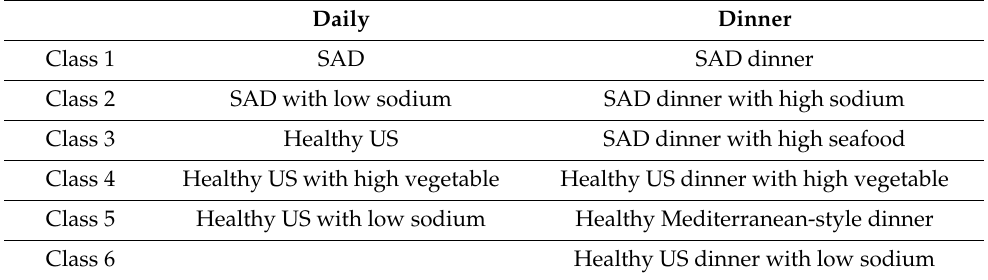
Table 4. Identified LCPA classes from daily and dinner meal calculated HEI-2010 from the NHANES